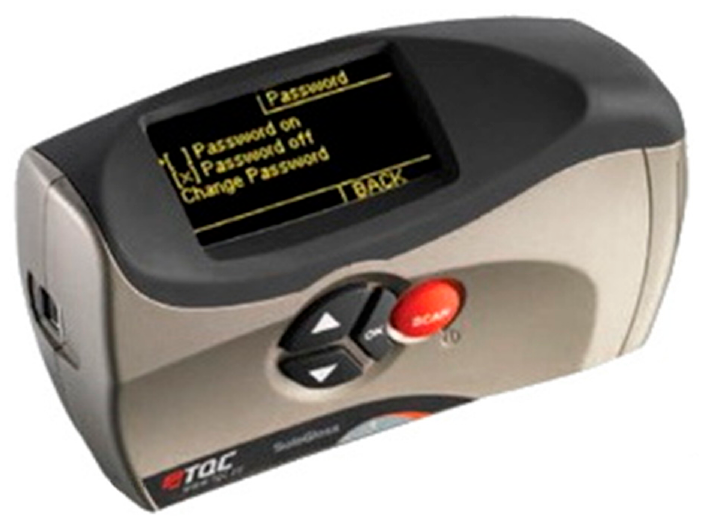
Figure 4. The TQC GL0030 glossmeter.